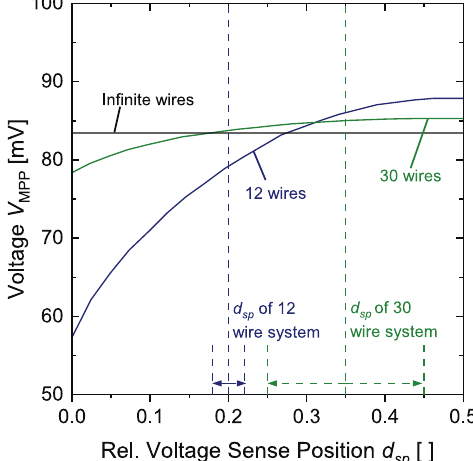
Fig. 9. Simulated fi ll factor distribution of a HJT cell without front metallization and R Sheet = 123/sq compared against fi ll factor of a fully contacted cell. The uncertainty of the voltage sense position is illustrated at the bottom.